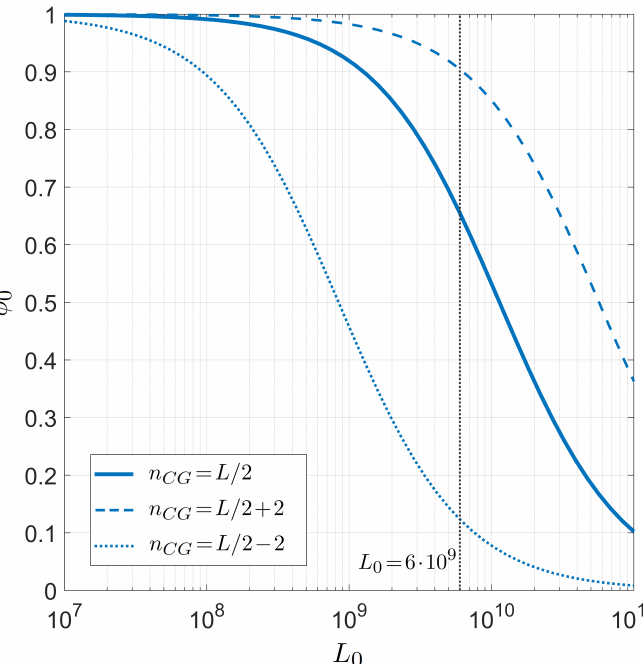
Figure 6. Dependence on the genome length L 0 of the on-target primer pairing probability condi- tioned on the well-paired 3 (cid:48) for PCR. Fixed values are considered for temperature T = 55 ◦ C, salt concentration [ Na + ] = 55 mM, and primer length L = 20, for different CG fractions in the primer. Solid line: CG fraction n CG = L /2. Dashed line: CG fraction n CG = L /2 + 2. Dotted line: CG fraction n CG = L /2 − 2. The gray line marks twice the length of the human genome, L 0 = 6 × 10 9